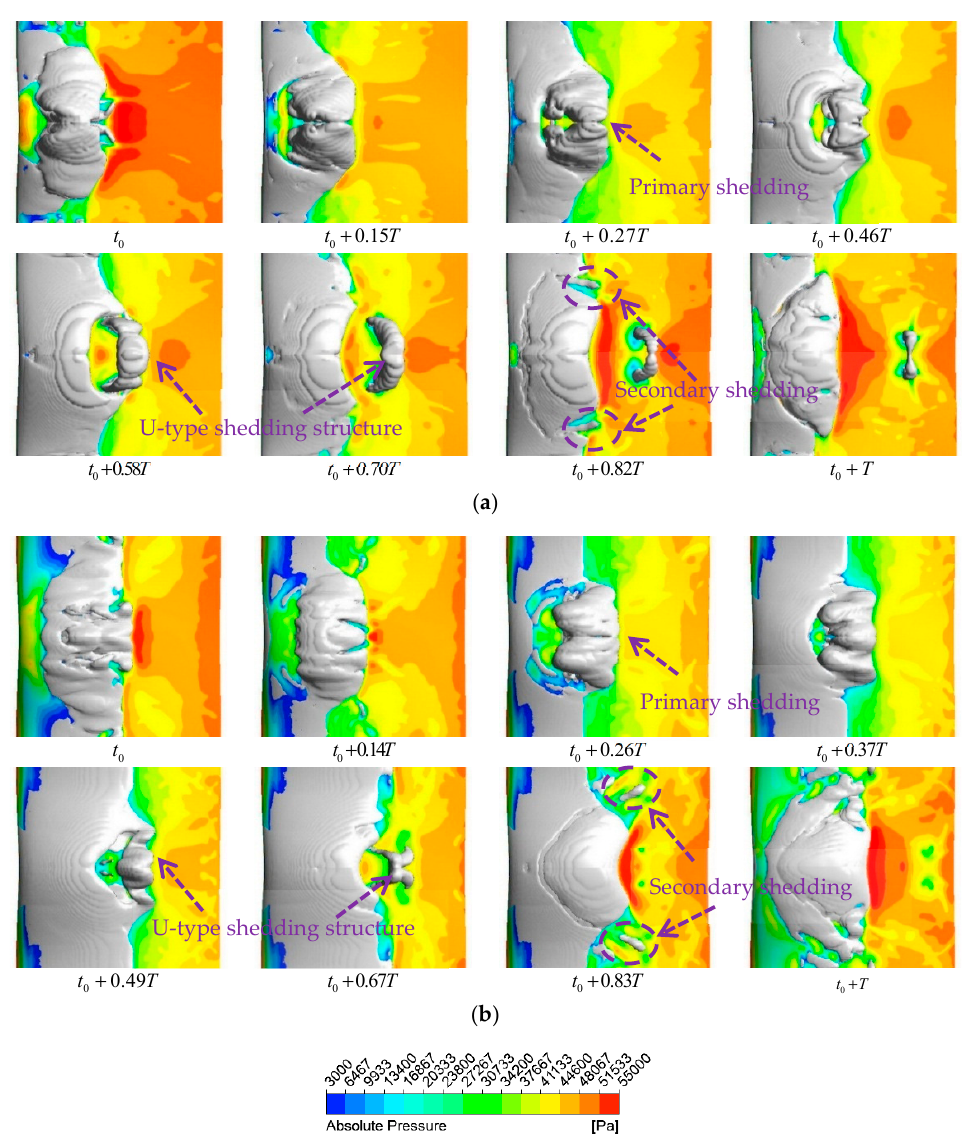
Figure 5. Top view of the transient cavity topology and pressure distributions of two different hydrofoils: ( a ) NACA0009 and ( b ) Clark-y.